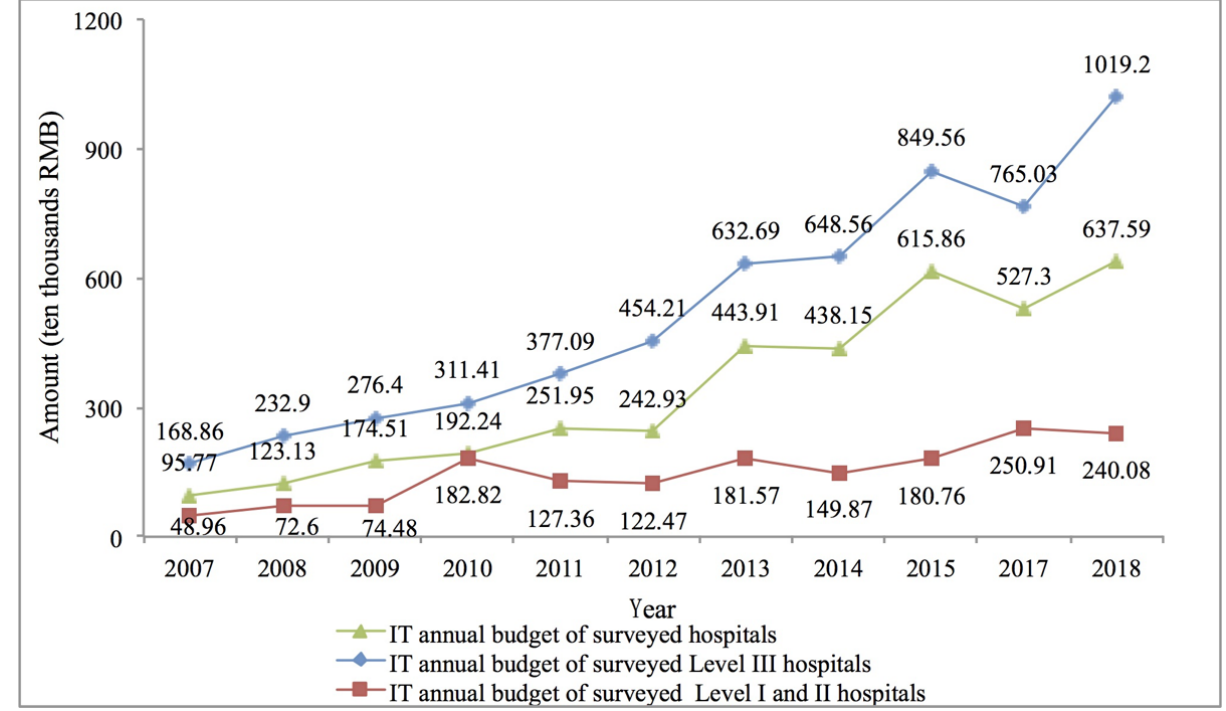
Figure 7. Health information technologies investment in Chinese hospitals from 2007 to 2018. IT: information